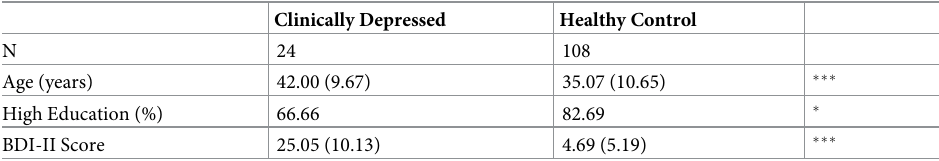
Table 4. Demographic and clinical characteristics of clinical sample.